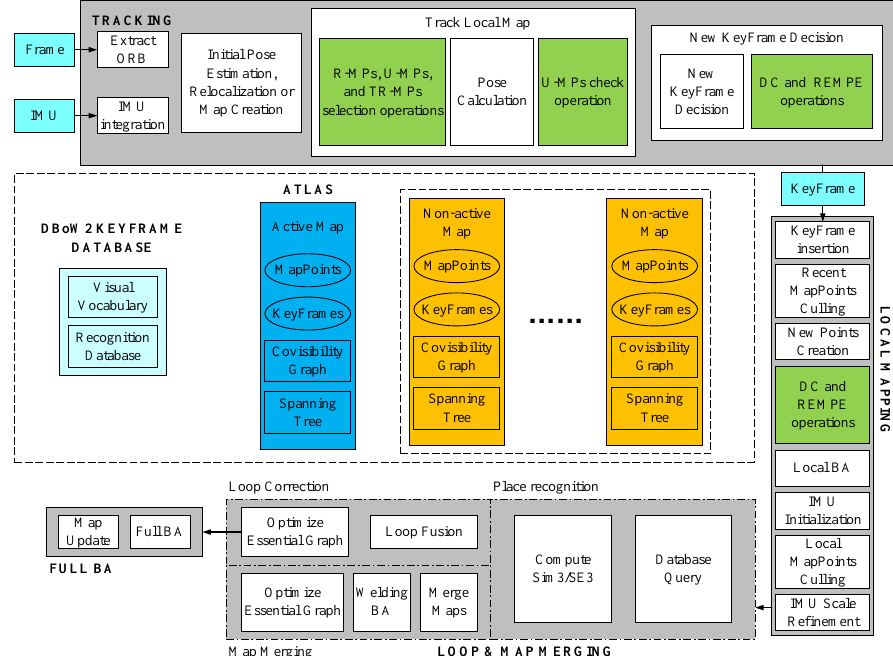
Figure 1. Framework overview of our proposed SLAM. The reliable map points are called R-MPs; the unreliable map points are called U-MPs; the temporary reliable map points are called TR-MPs; DC represents the distance check operation; REMPE represents the repeated existing map points elimination